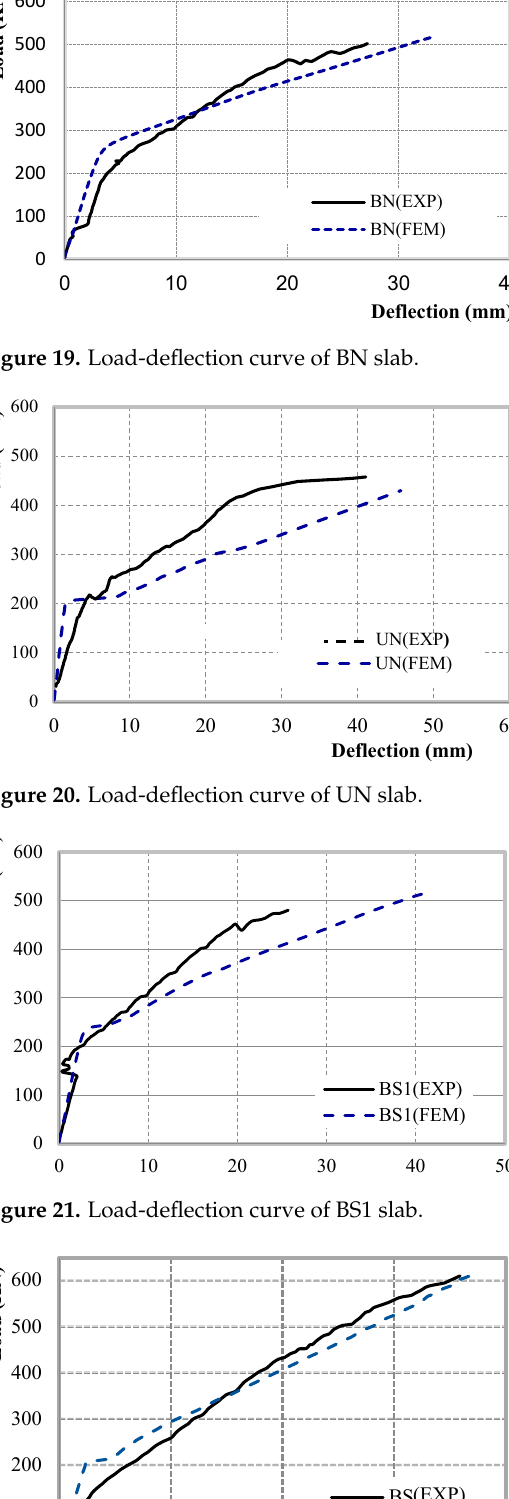
Figure 18. Deformation shape of US slab.